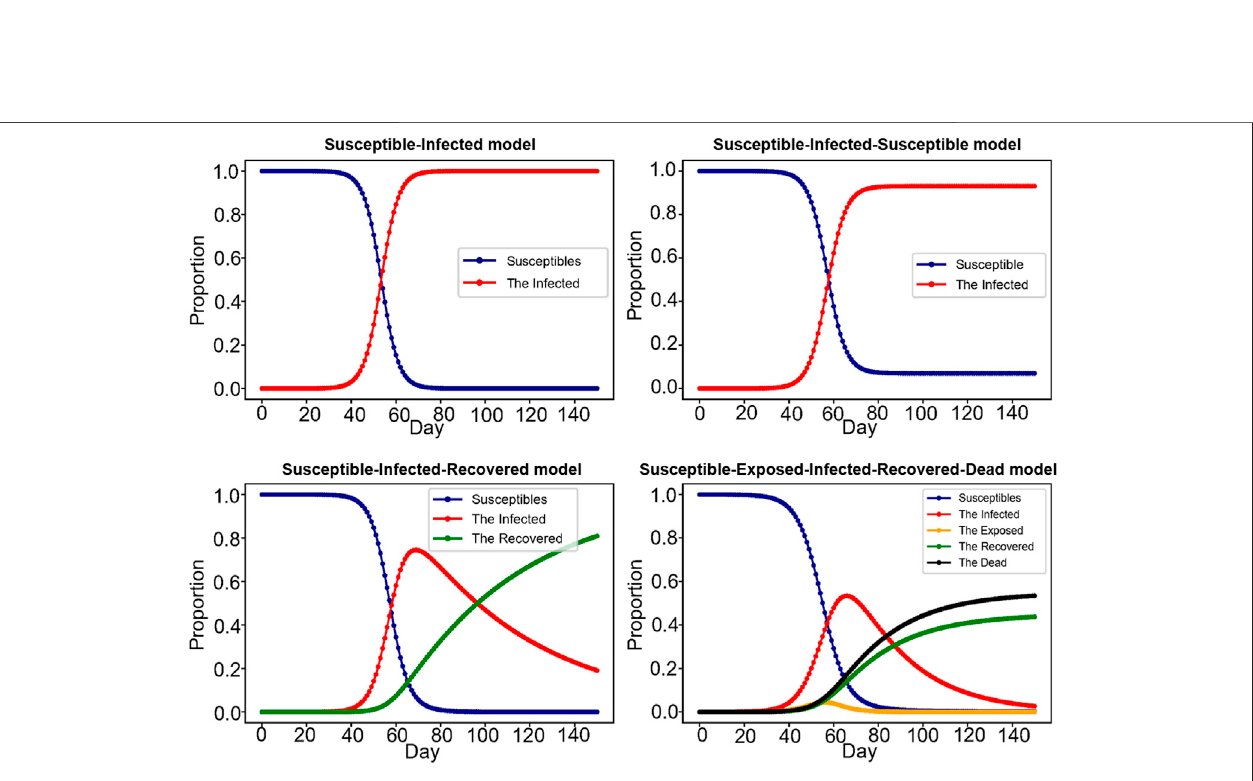
FIGURE7| Mathematical model.Thepictureshowsfourclassicmodelsofinfectiousdiseases,Susceptible-Infectedmodel(SI),Susceptible-Infected-Susceptible model (SIS), Susceptible-Infected-Recovered model (SIR), Susceptible-Exposed-Infected-Recovered-Dead model (SEIRD), with each letter representing a state. For example, SEIRD model represents susceptible, infected, exposed, recovered, and